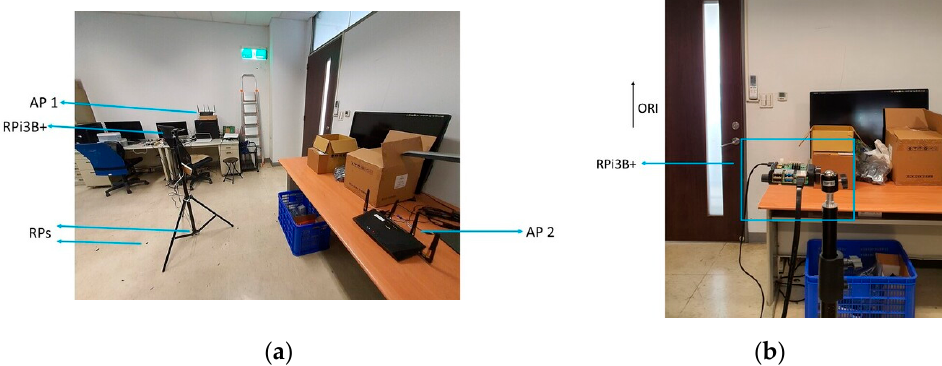
Figure 4. ( a ) Photo of the actual experimental environment; ( b ) photo of the setup of RPi3B+ with orientation ORI.